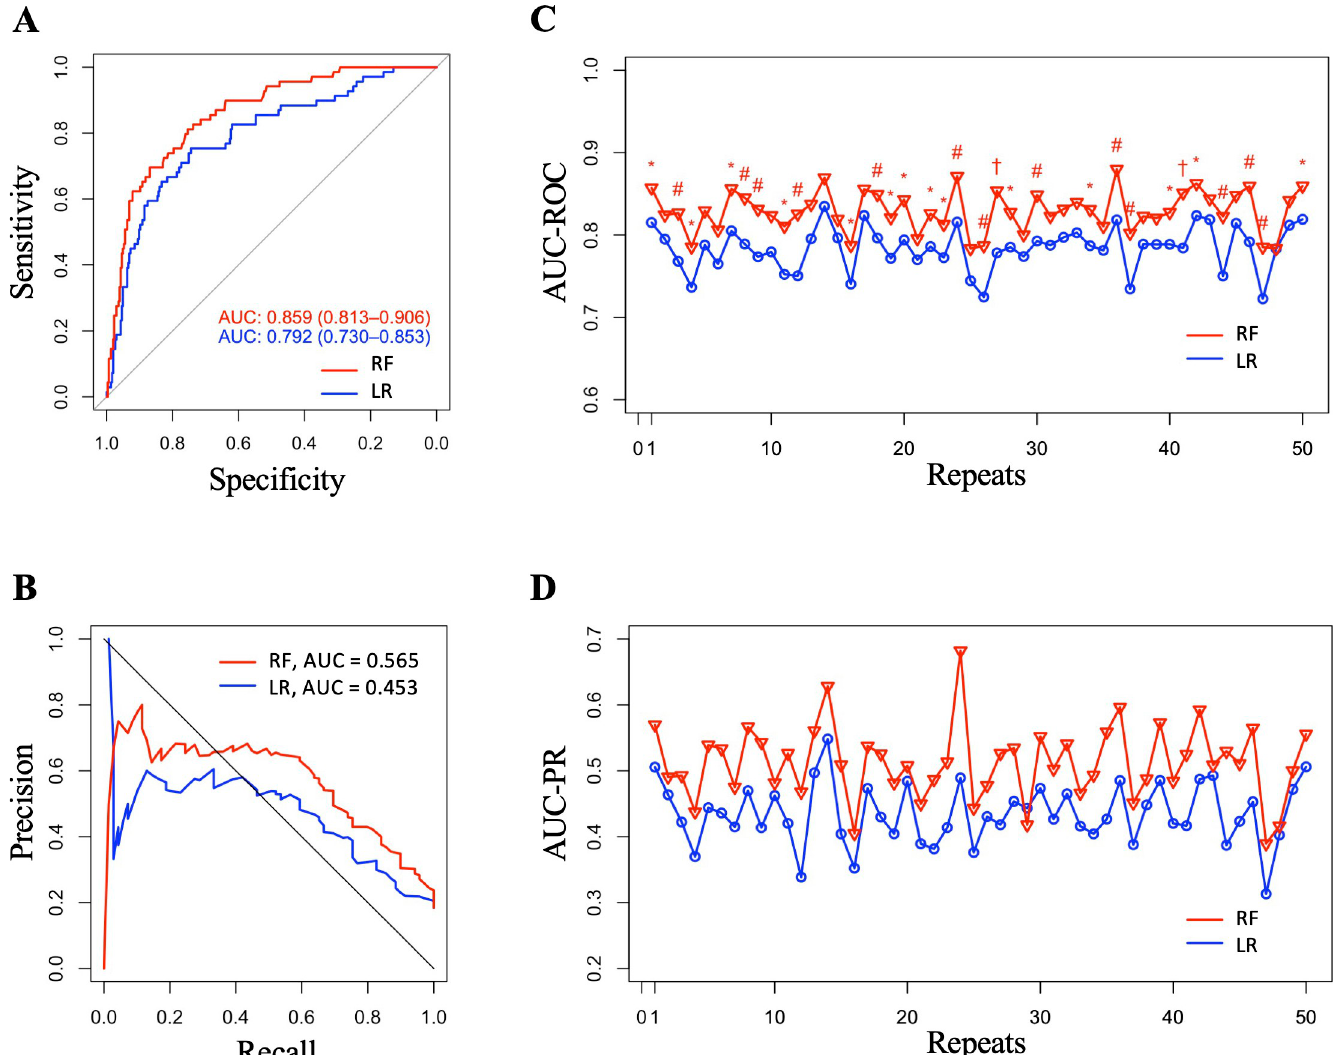
Fig 2. Analysis of the ROC and PR curves. The representative ROC (A) and PR curve (B) from 1 of the 50 test datasets are shown. The AUC-ROC (C) and AUC-PR (D) in the 50 test datasets were presented. The X-axis denotes each test dataset. The Y-axis denotes the value of AUC-ROC or AUC-PR. The AUC-ROCs between the RF and LR models were compared by the DeLong test. � P < 0.05, # P < 0.01, † P < 0.001. Abbreviations: AUC = area under the curve; LR = logistic regression; RF = random forest; ROC = receiver operating characteristic; PR = precision-recall.